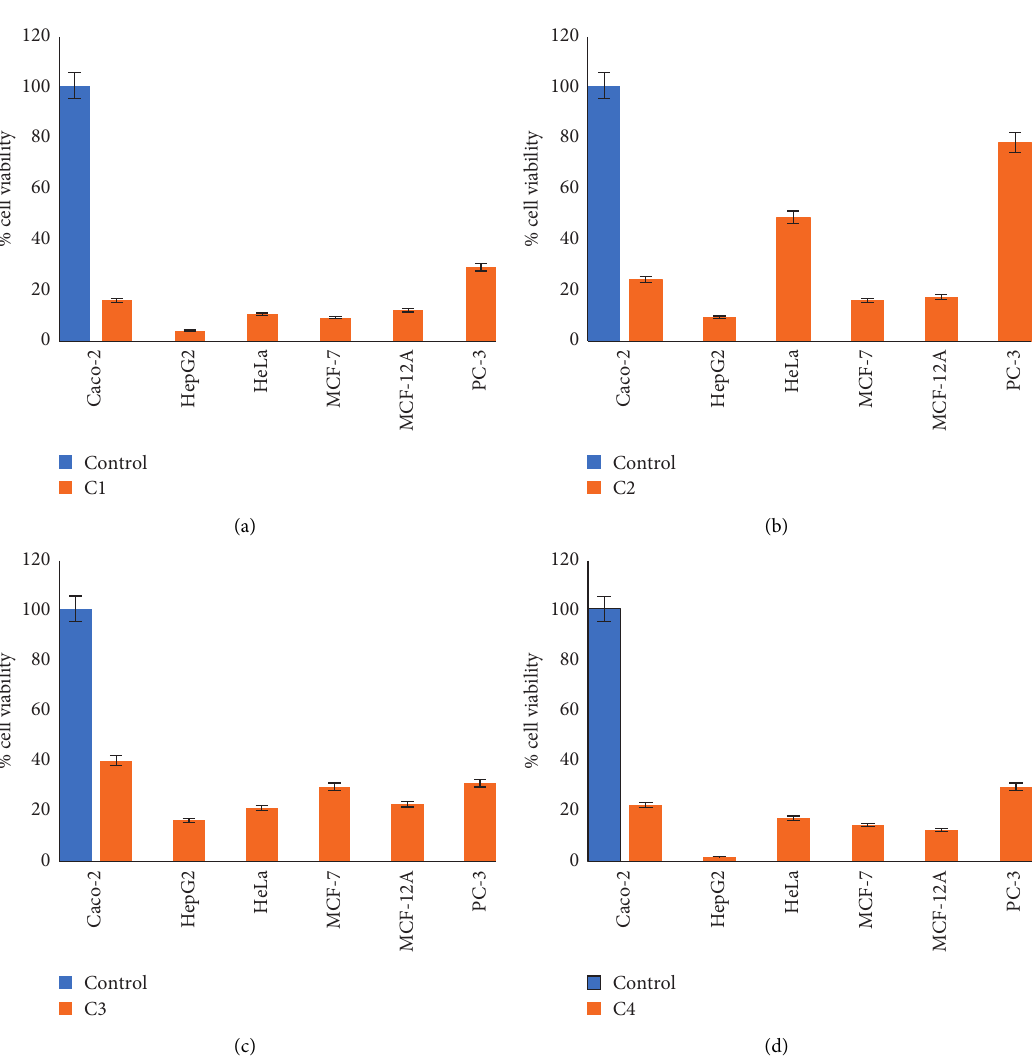
Figure 9: Percent cell viability for the different compounds ( C1–C4 ) after 24h of treatment assessed by the colorimetric MTTassay: (a) C1; (b) C2; (c) C3; (d) C4. Table 3: The IC 50 values for ligands and complexes C1–C4